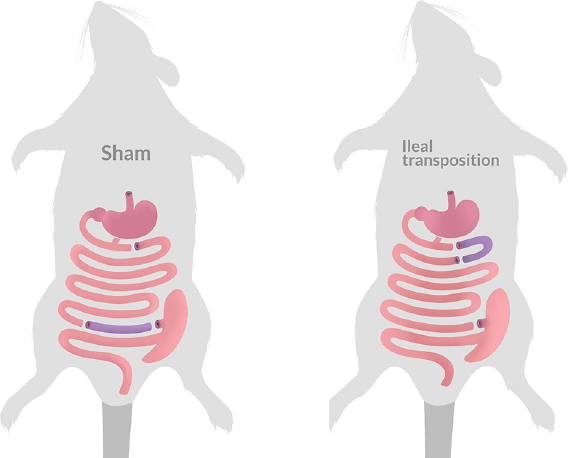
Figure 5. Scheme of ileal transposition (IT) and control (SHAM) surgery performed in Zucker (Crl:ZUC(ORL)-Lepr fa ) rats. Detailed description of each type of surgery can be found in the “Materials and method”